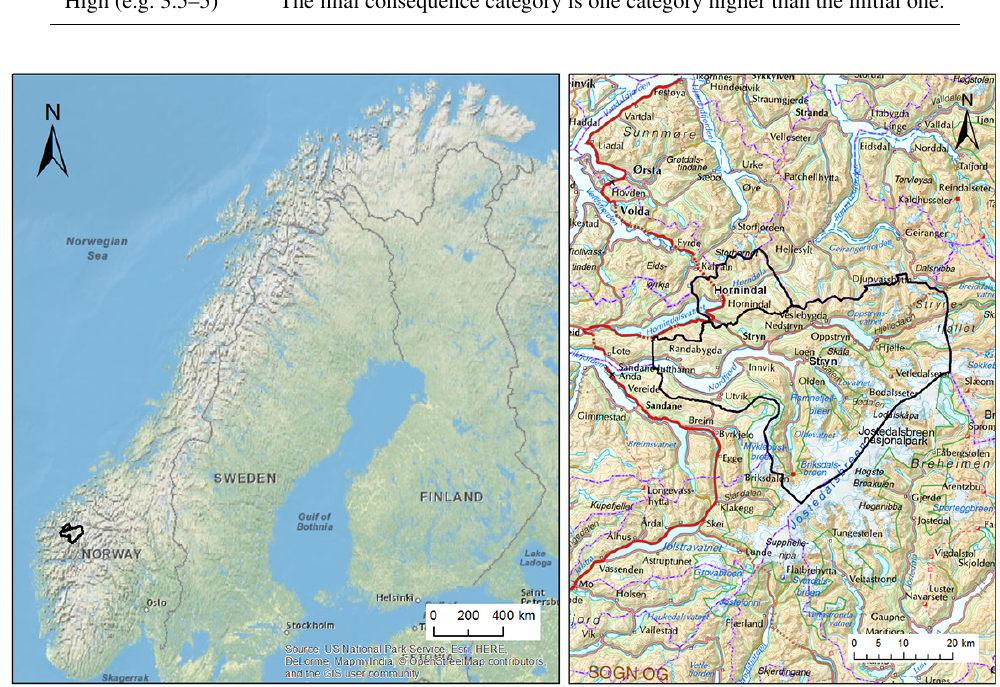
Figure 3. Location of the study area in Norway (left panel source: ESRI) and the spatial extent of Stryn and Hornindal municipalities in Western Norway (right panel source: The Norwegian Mapping